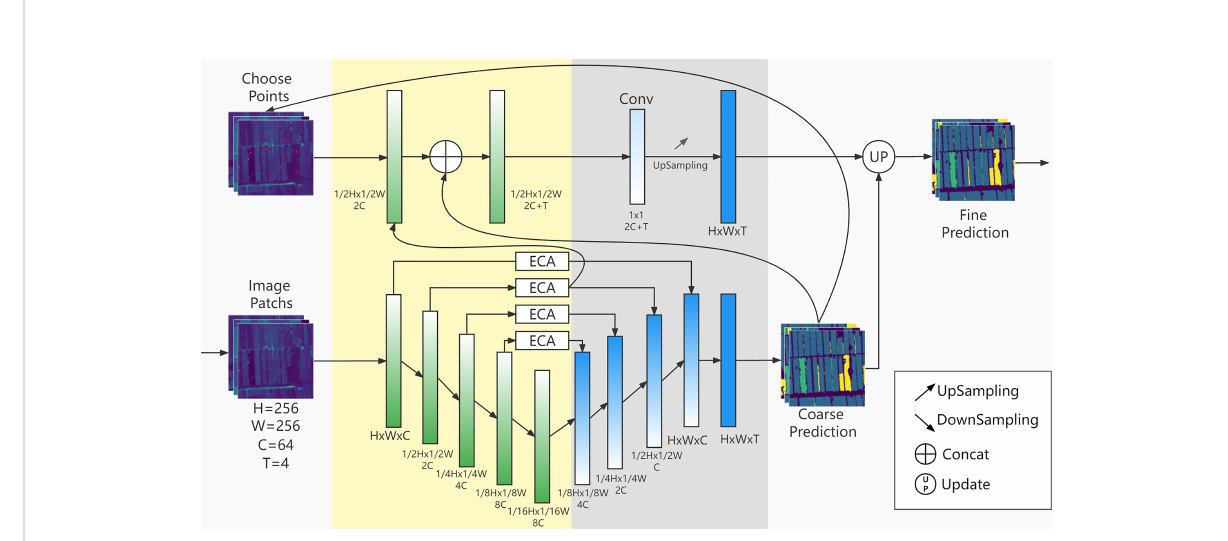
FIGURE 3 CACPU-Net. The yellow part is the network encoder, and the gray part is the network decoder. The upper part is the CP Module structure, and the lower part is the Baseline Network structure.